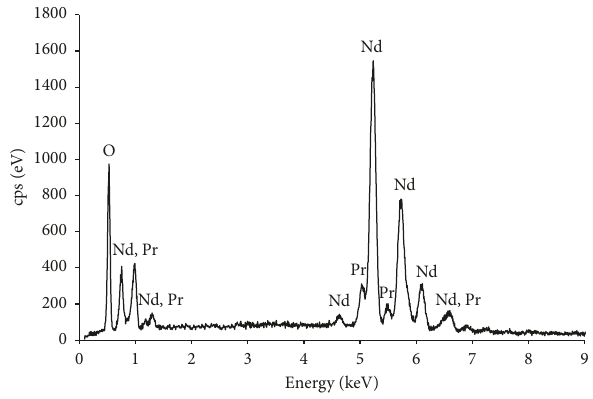
Figure 4: EDS spectrum of the rare earth oxides from permanent